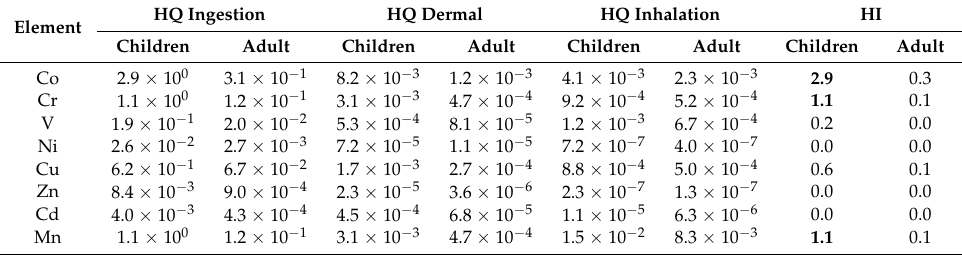
Table 4. HQ values for various pathways and elements and HI for elements from Santiago Island. HQ Ingestion HQ Dermal HQ Element